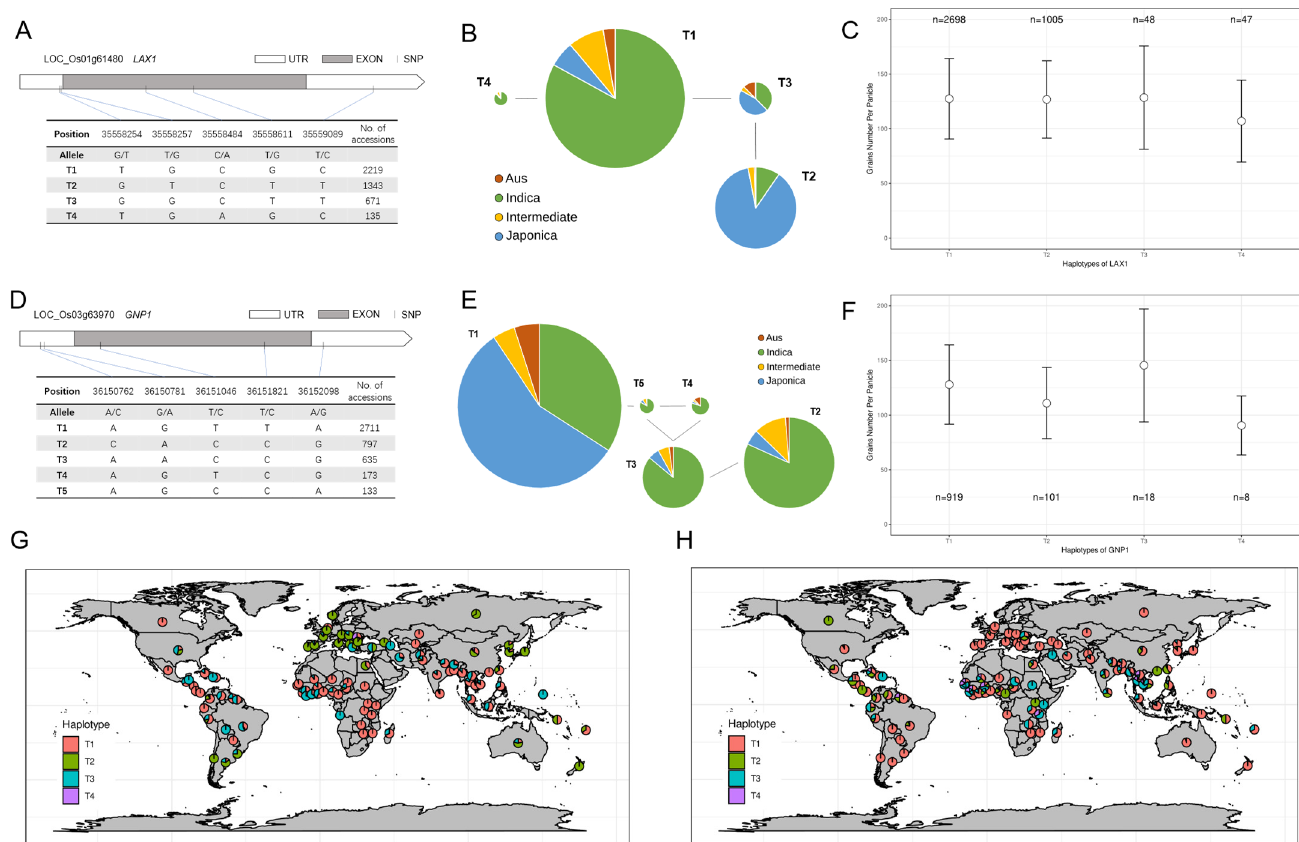
Figure 3. Haplotype analysis of LAX1 and GNP1 using the MBK database. The number of haplotypes of the LAX1 ( A ) and GNP1 ( D ) gene is based on the SNP positions in the MBK database. The relationship between the LAX1/GNP1 haplotypes ( B , E ); ( C ) the difference in GNPP among the LAX1 ( C ) and GNP1 ( F ) haplotypes recorded in MBK; n means the number of records. The geographical distribution of various haplotypes of LAX1 ( G ) and GNP1 ( H ).